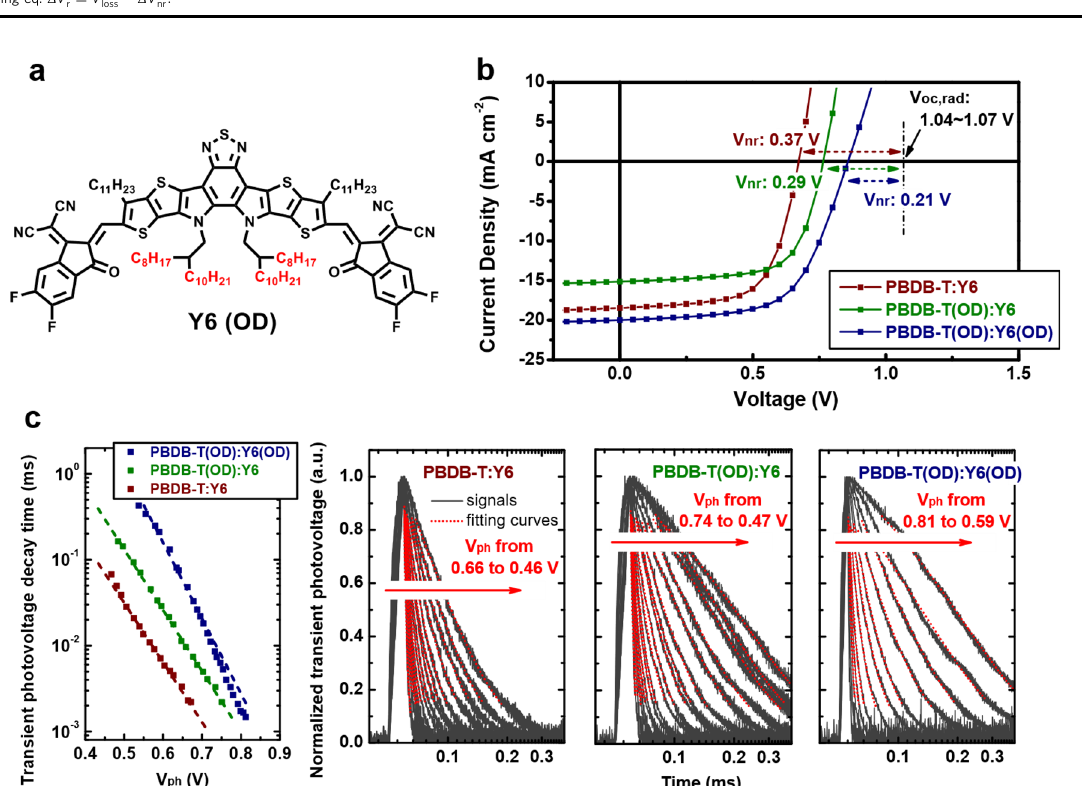
Fig. 4 Impact of side-chain modi fi cation on the performance of BHJ organic solar cells. a Chemical structure of Y6(OD) with side chains considerably large than Y6. b JV curves of the solar cells based on PBDB-T, PBDB-T(OD), mixed with Y6 and Y6(OD). 4 V indicated. c TPV measurements performed on the solar cells based on the active materials with and without the side chain modi fi cation, the voltage decay lifetime values (left) are derived from the transient signals (right) of the solar cells measured under different steady-state illumination intensities (to generate different steady-state photovoltage, ( V ph )). The dash lines in the left plot are a guide to the eyes, and details regarding the measurements are provided in Supplementary Note